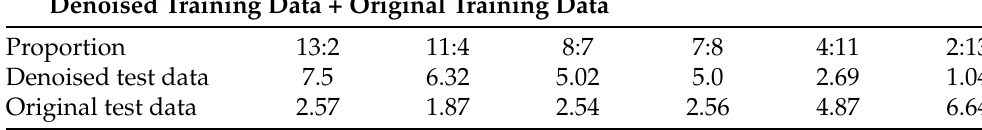
Table 5. Pre-processing strategy study.